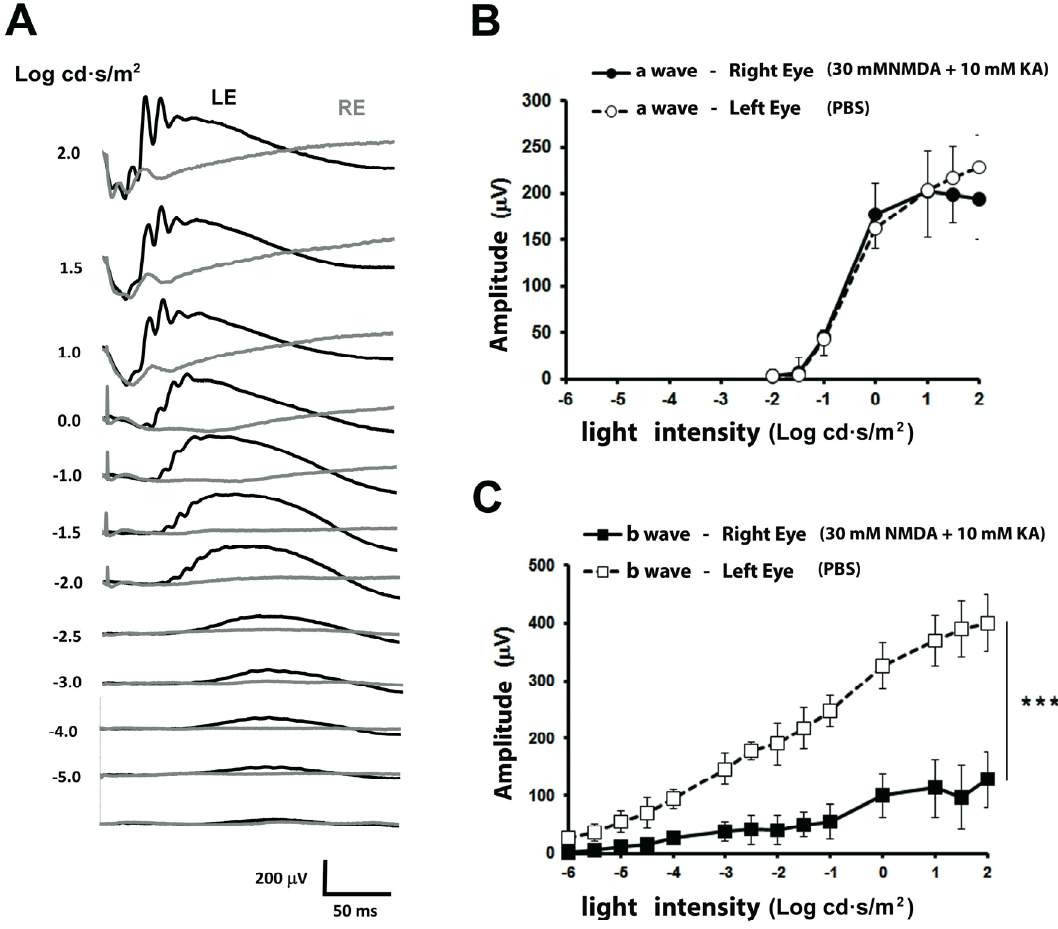
Figure 1. Scotopic electroretinographic responses after intraocular injection of NMDA and Kainate. ( A ) Electroretinographic recordings obtained from the right eye injected with 30 mM NMDA and 10 mM KA (RE, gray trace) and left eye injected with PBS (LE, control, black trace) in response to increasing light intensities (shown to the left of each record in Log cd · s / m 2 ). ( B ) Relationship between the amplitude of the a-wave and the light intensity showing no di ff erences between eyes. ( C ) Relationship between the amplitude of the scotopic b-wave and the light intensity. The values shown in ( B , C ) correspond to the mean and the standard deviation, n = 8.